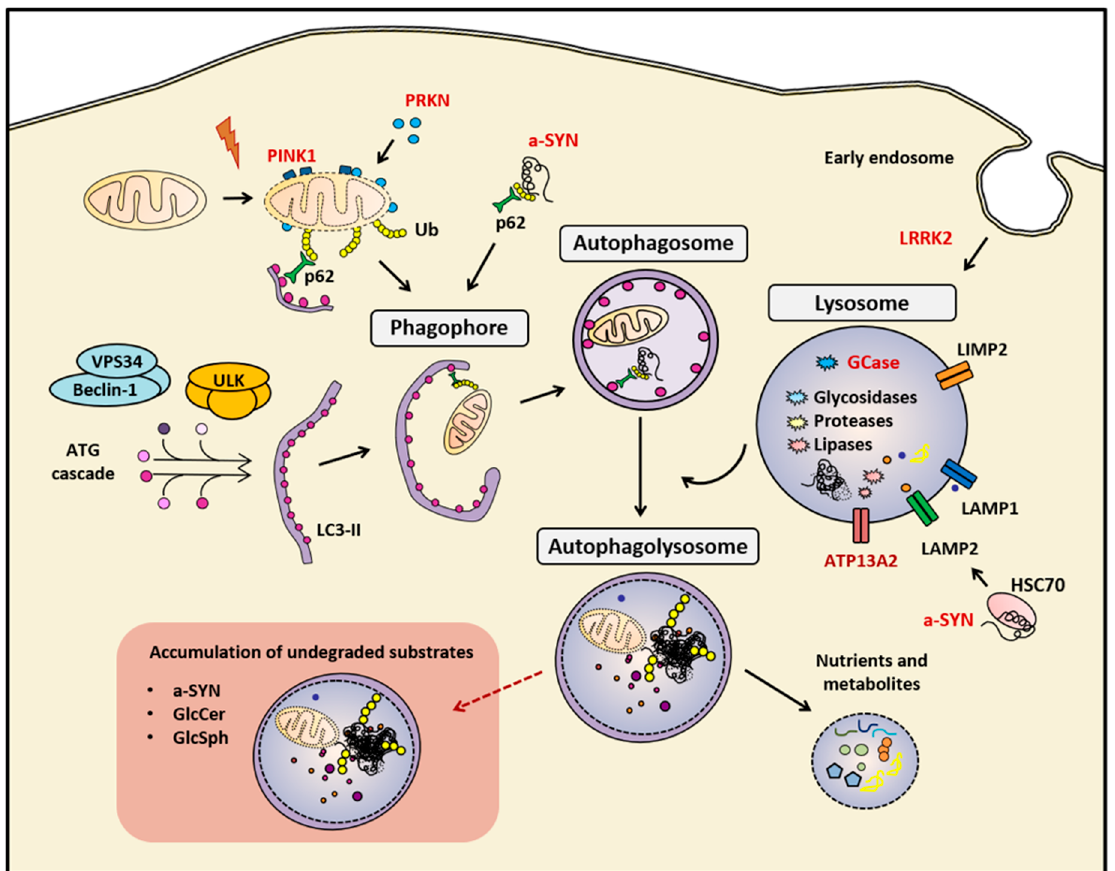
Figure 1. Summary of the main mentioned markers of the autophagy-lysosomal pathway (ALP). The correct function of the ALP is essential for maintaining cellular homeostasis. In cases of genetic or sporadic Parkinson’s disease (PD), the impairment of this biological process leads to the accumulation of undegraded cellular components, such as protein aggregates, and dysfunctional organelles, such as mitocondria. Red-colored proteins are genetically linked to PD. a-SYN (alpha-synuclein), Autophagy proteins (ATG), Cation-transporting ATPase 13A2 (ATP13A2), E3 ubiquitin-protein ligase parkin (PRKN), Ubiquitin (Ub), Glucosylceramide (GlcCer) and Glucosylsphingosine (GlcSph), Heat-shock cognate protein of 70 kilodalton (HSC70), LC3-phosphatidylethanolamine conjugate (LC3-II), Leucine-rich repeat kinase 2 (LRRK2), Lysosomal hydrolase glucocerebrosidase (GCase), Lysosomal integral membrane protein-2 (LIMP-2), Lysosomal-associated membrane protein 1 (LAMP1), Lysosome-associated membrane protein 2 (LAMP2), Phosphatase and tensin homolog (PTEN)-induced kinase 1 (PINK1), Ubiquitin-binding protein p62 or Sequestosome 1 (p62), Unc-51-like kinase (ULK), Vacuolar sorting protein 34 (VPS34)